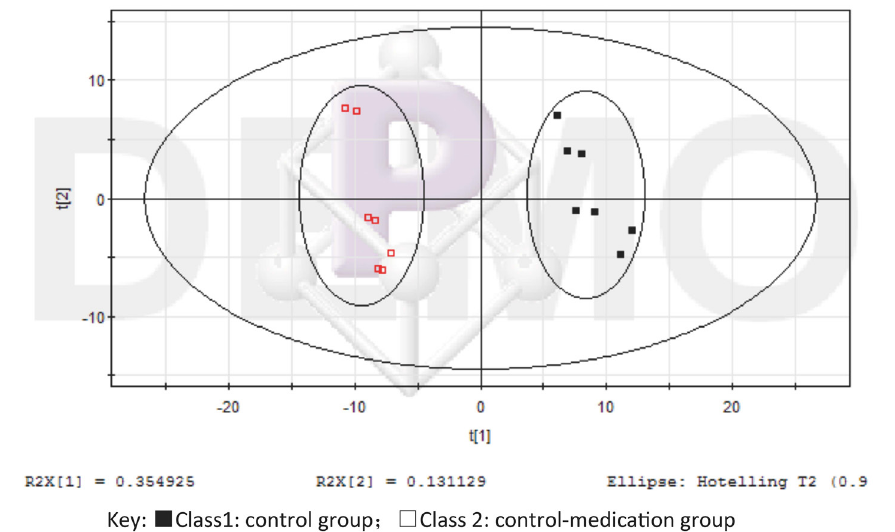
FIGURE 4 - Score plot of the first two values of the proton nuclear magnetic resonance ( 1 H NMR) spectra of serum samples from the control and control-medication